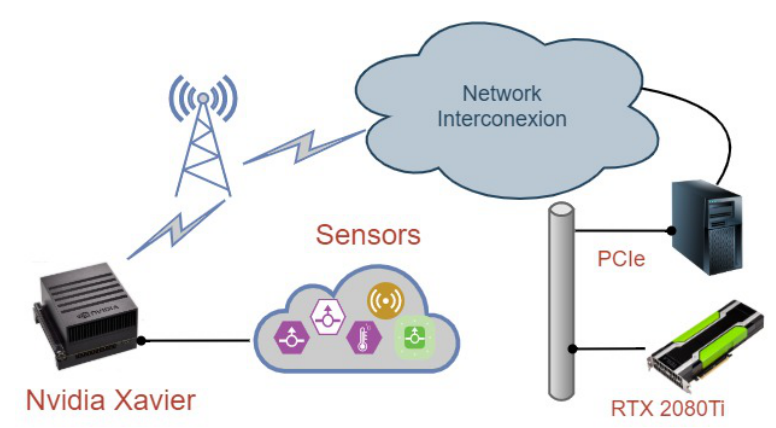
Figure 1. The system infrastructure in a